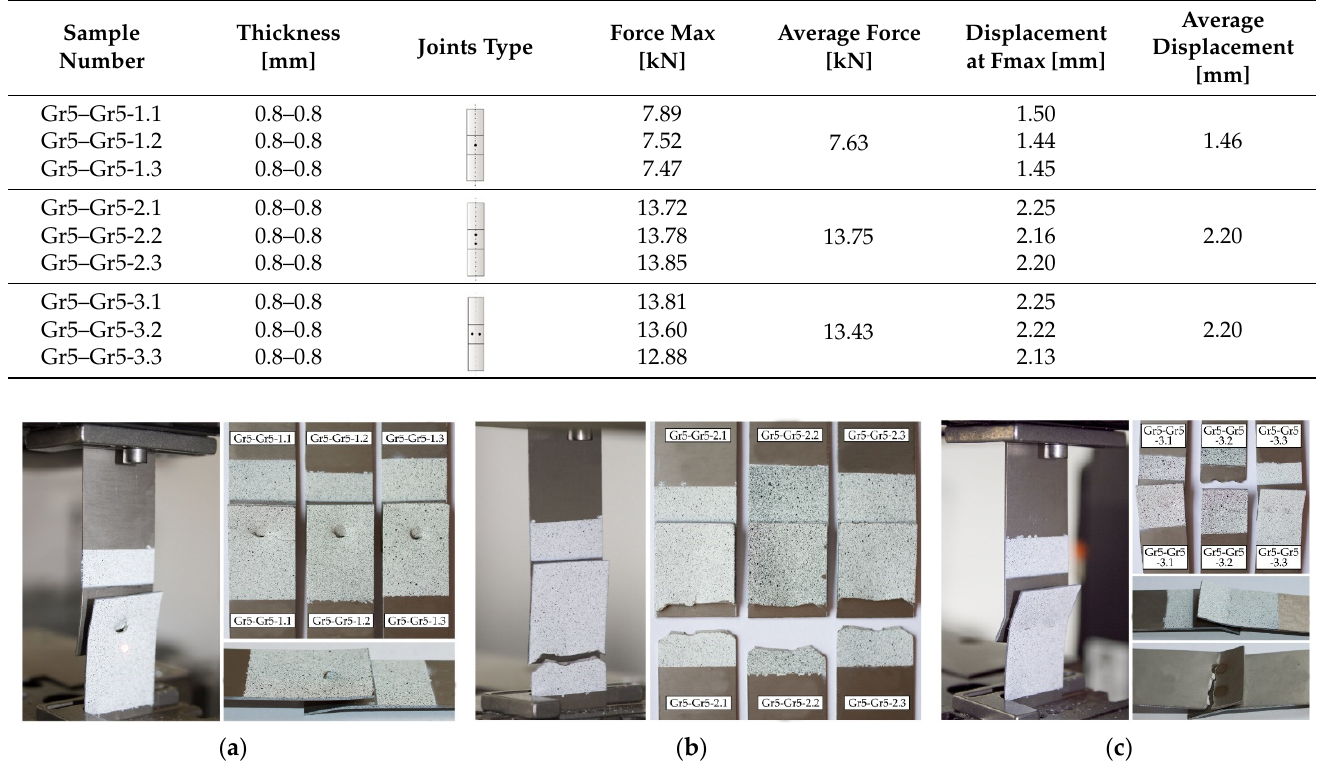
Table 7. Results from the tensile shear test of Gr5–Gr5 joints.